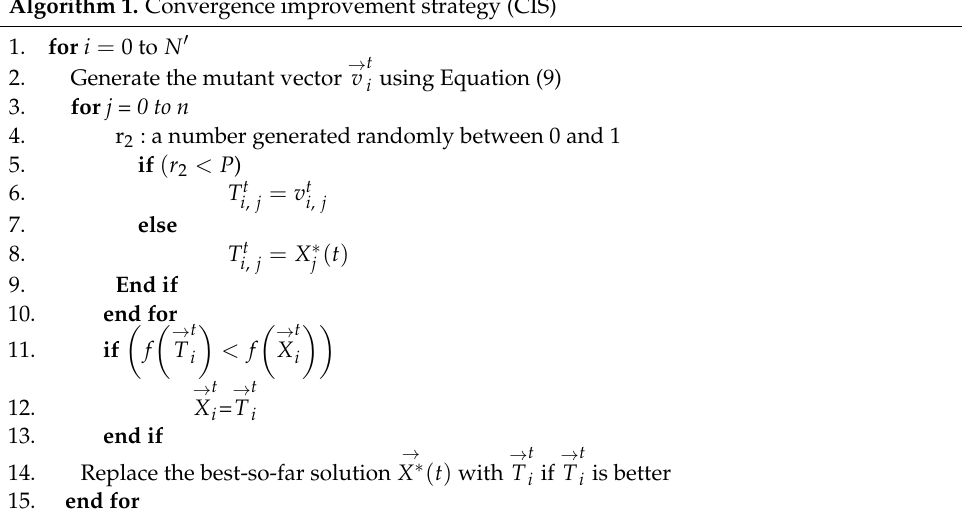
Algorithm 1. Convergence improvement strategy